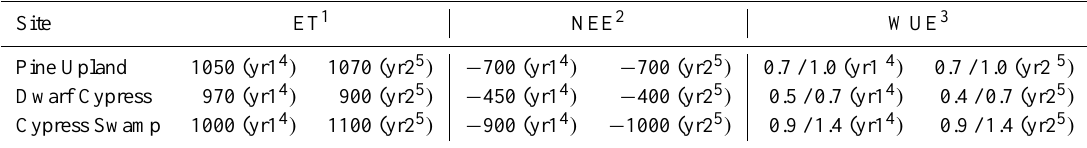
Table 5. ET, NEE and WUE at the flux stations. Site ET 1 NEE 2 WUE 3 Pine Upland 1050 (yr1 4 ) 1070 (yr2 5 ) − 700 (yr1 4 ) − 700 (yr2 5 ) 0.7 / 1.0 (yr1 4 ) 0.7 / 1.0 (yr2 5 ) Dwarf Cypress 970 (yr1 4 ) 900 (yr2 5 ) − 450 (yr1 4 ) − 400 (yr2 5 ) 0.5 / 0.7 (yr1 4 ) 0.4 / 0.7 (yr2 5 ) Cypress Swamp 1000 (yr1 4 ) 1100 (yr2 5 ) − 900 (yr1 4 ) − 1000 (yr2 5 ) 0.9 / 1.4 (yr1 4 ) 0.9 / 1.4 (yr2 5